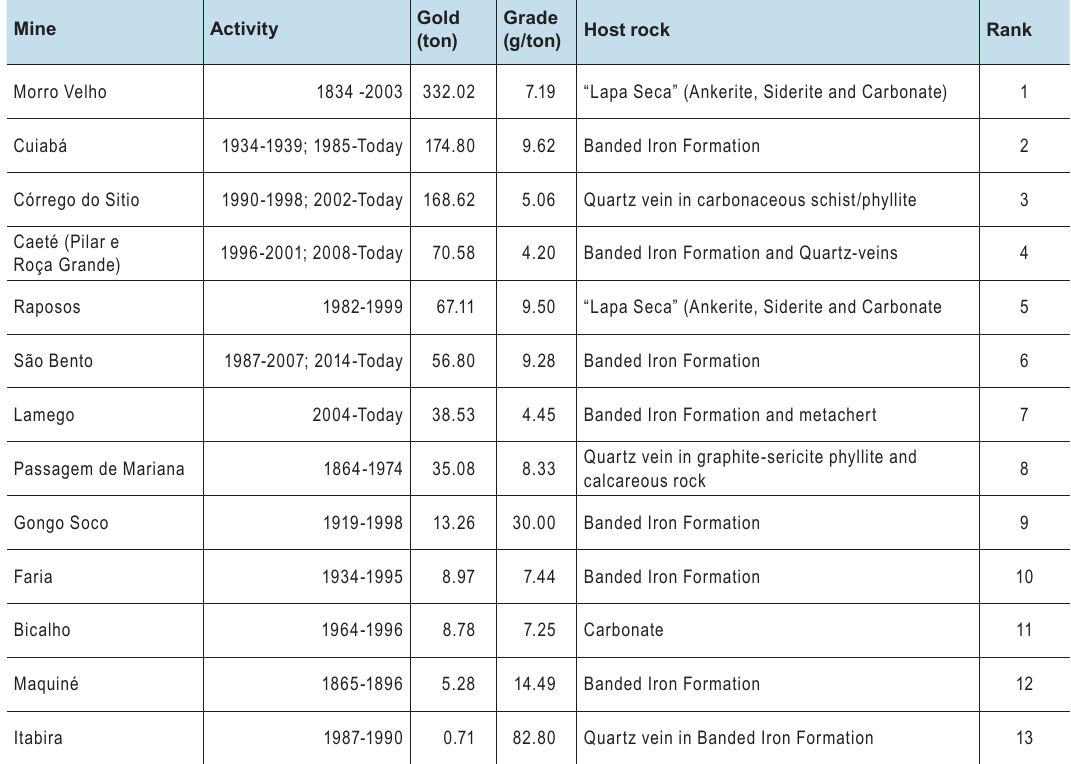
TABLE 1 - Main orogenic gold deposits of the Quadrilátero Ferrífero Province and their respective ranks (modified from Lobato et al.,